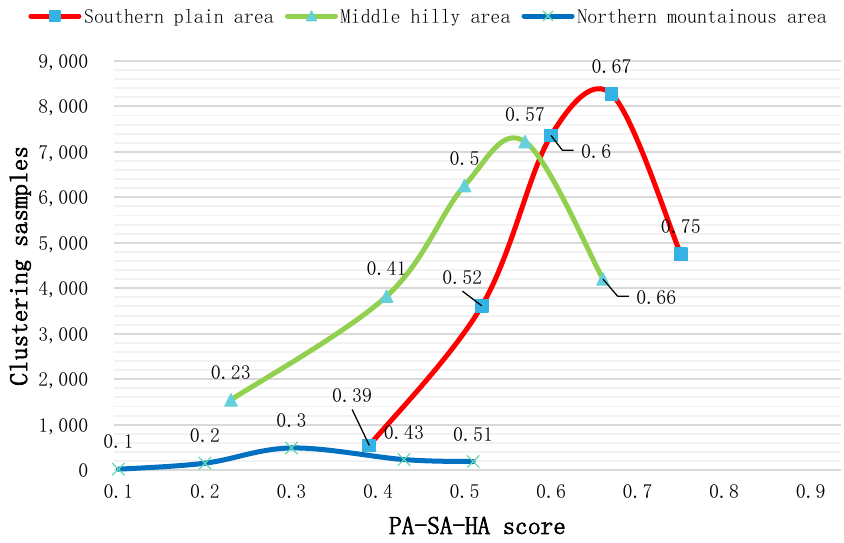
Figure 7. Clustering scores of the coupling coordination index of PA-HA-SA.